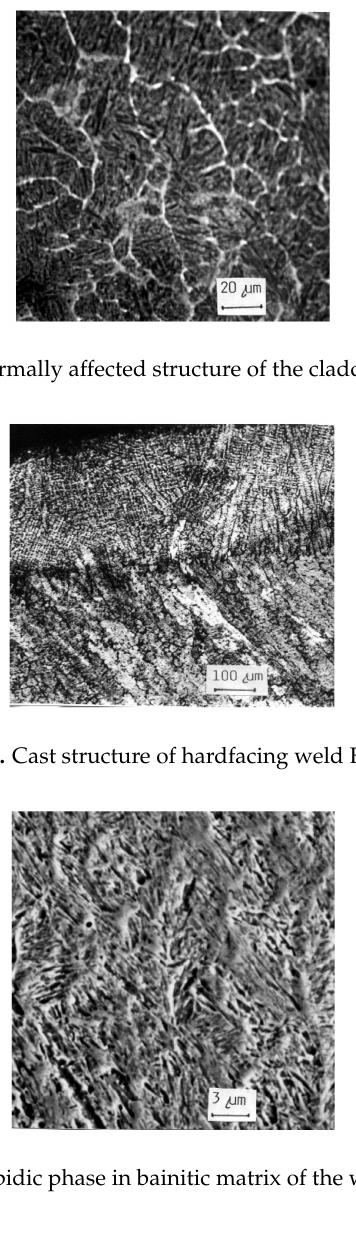
Figure 5. Microstructure of hardfacing weld E 508 B.